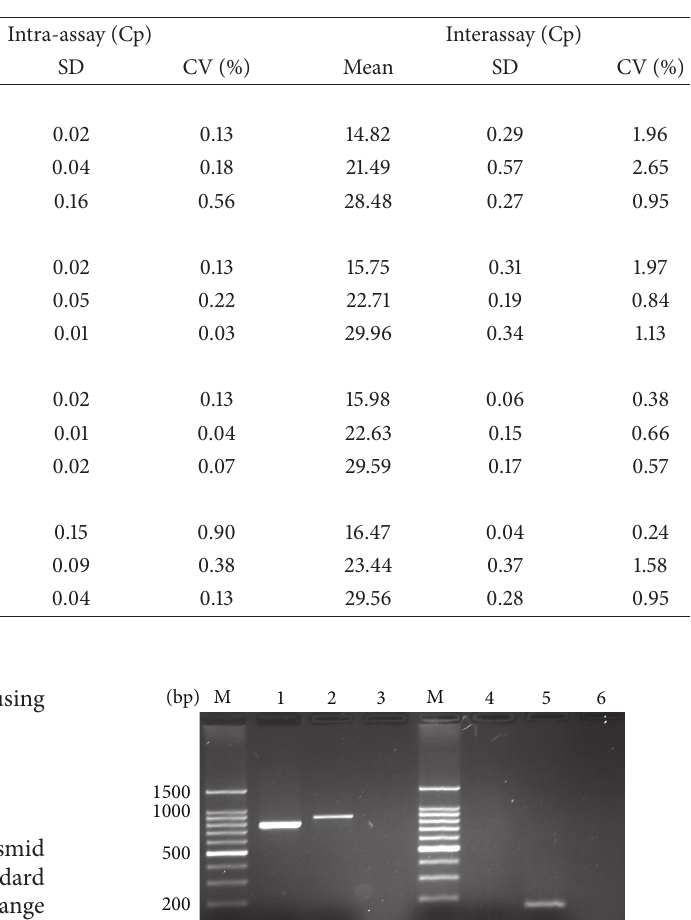
Table 2: Intra- and interassay reproducibility of real-time PCR.